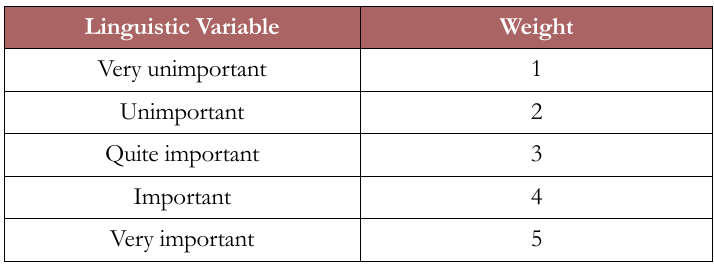
Table 6. Measurement of Alternative